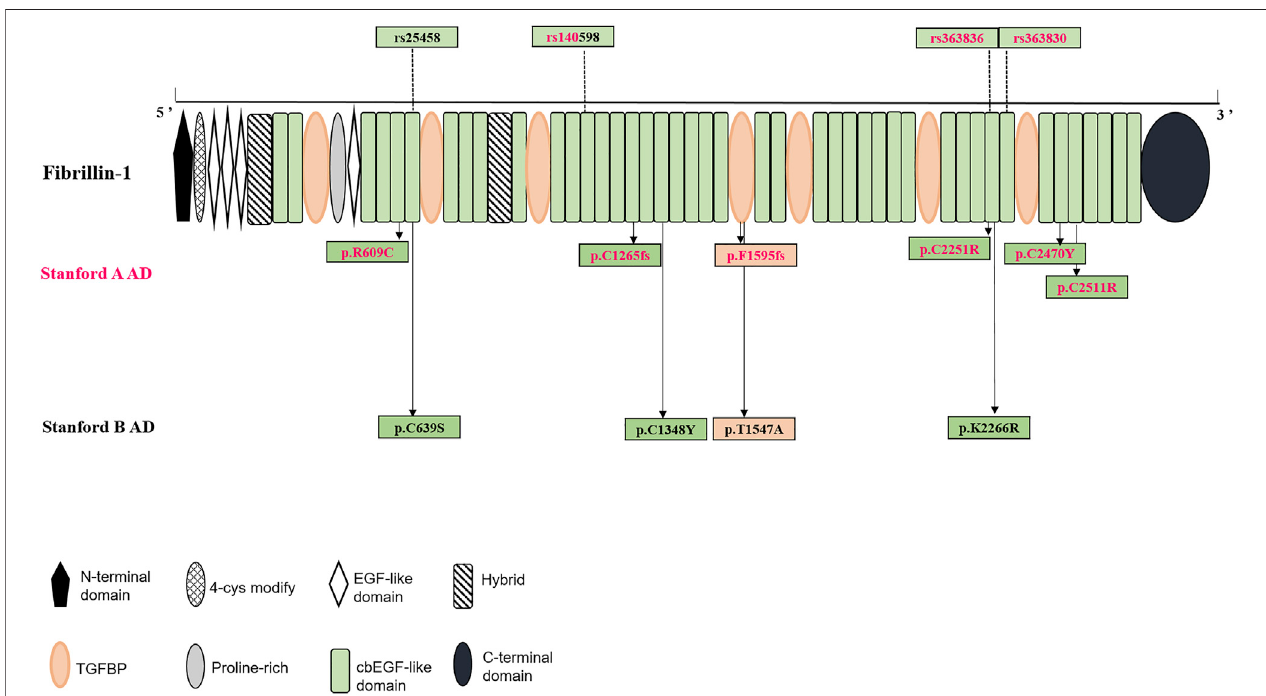
FIGURE 1 | Structural domain of fi brillin-1 (encoded by FBN1 gene) and distribution of both positive variants and signi fi cant SNPs in the protein were shown.